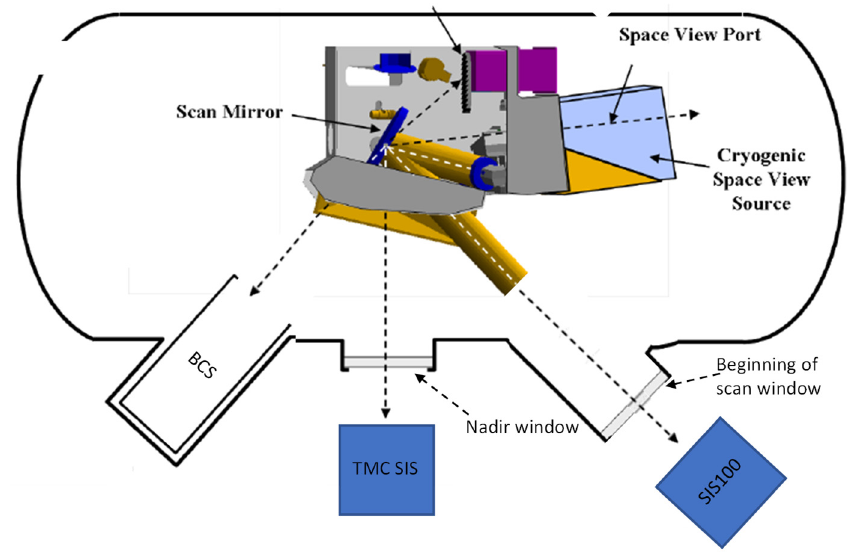
Figure 4. A cartoon of the VIIRS TVAC test chamber setup. The SV, TMCBB, and SIS100 sources are shown with respect to the instrument location within the chamber.